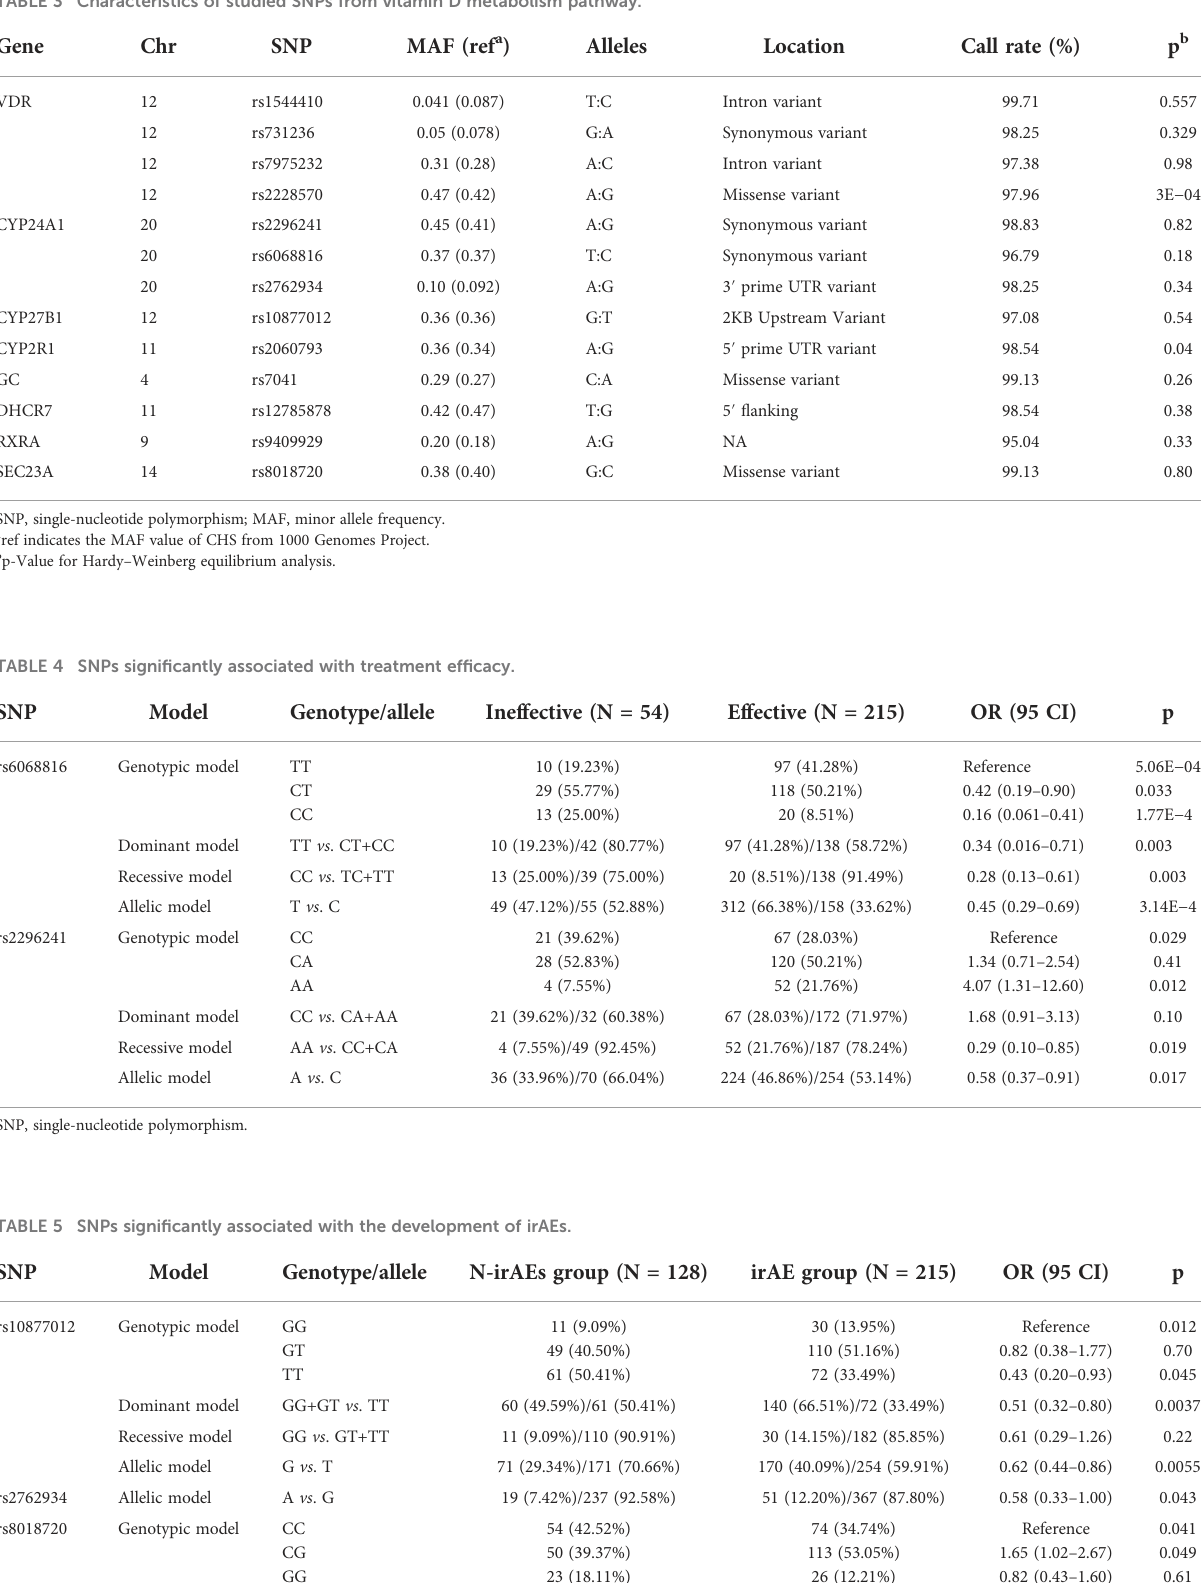
TABLE 3 Characteristics of studied SNPs from vitamin D metabolism pathway.